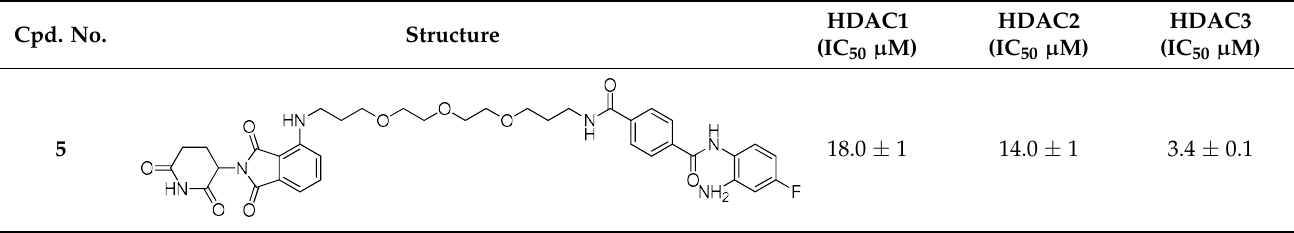
Table 1 . Inhibitory activity of compound ( 5 ) against HDAC 1, 2, and 3. Cpd.